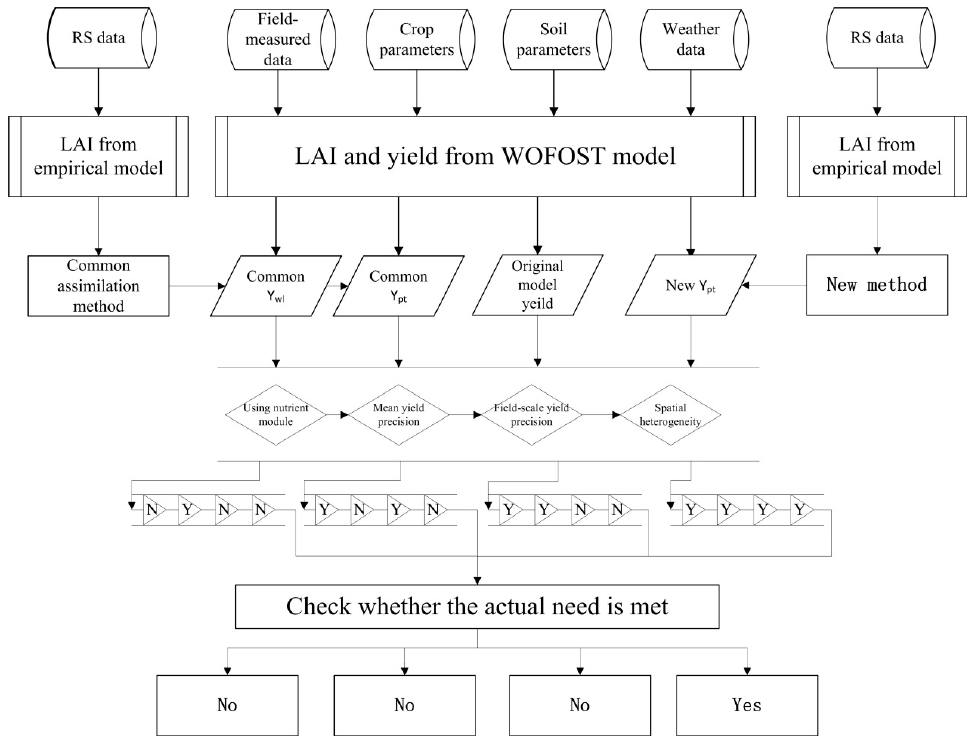
Figure 4. Process of selecting the new method.